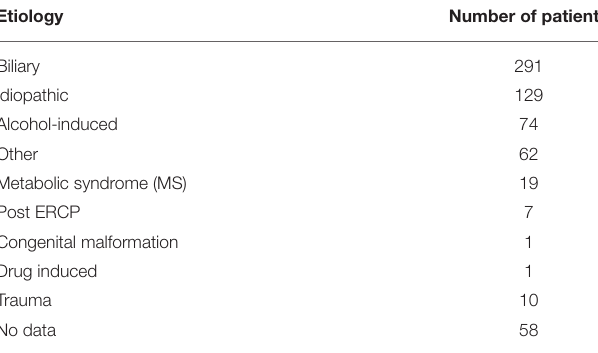
TABLE 1 | Causes of acute pancreatitis.